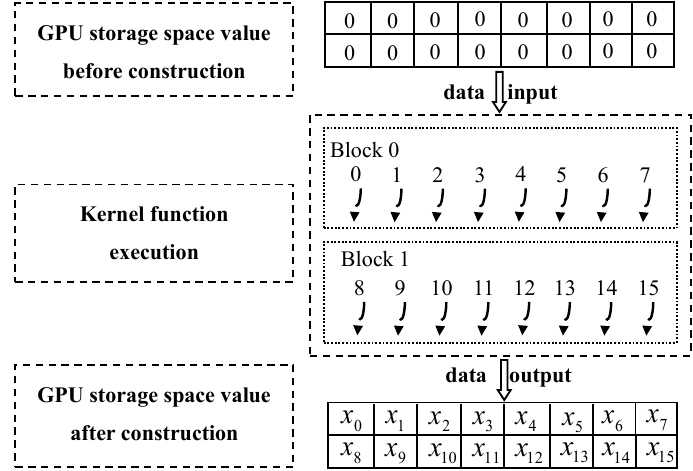
Figure 9. Schematic diagram of the 2 ∗ 8 matrix parallel construction